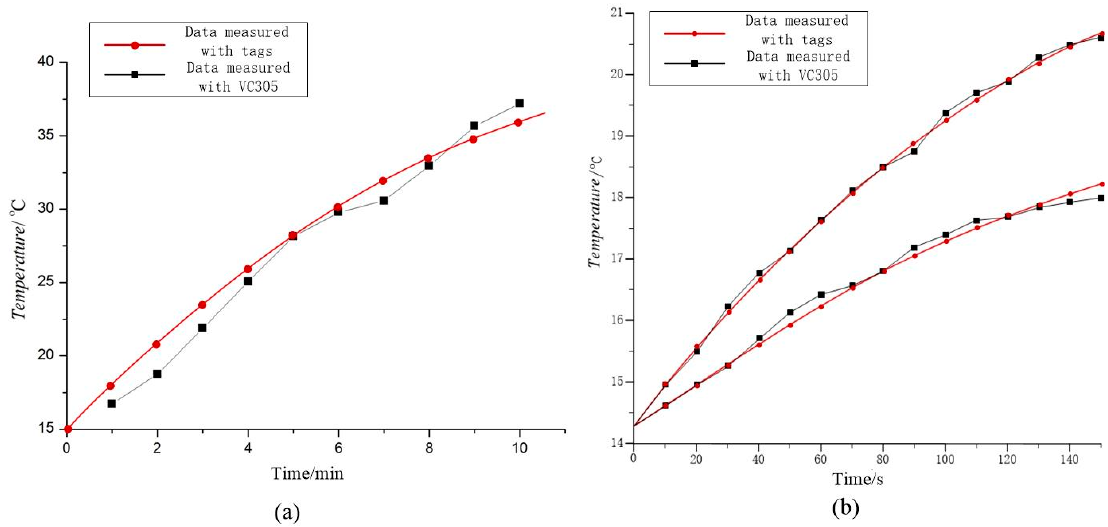
Figure 14. Temperature measurement: ( a ) Measured without wind; ( b ) Measured in wind (2.9 m/s, 6.2 m/s).